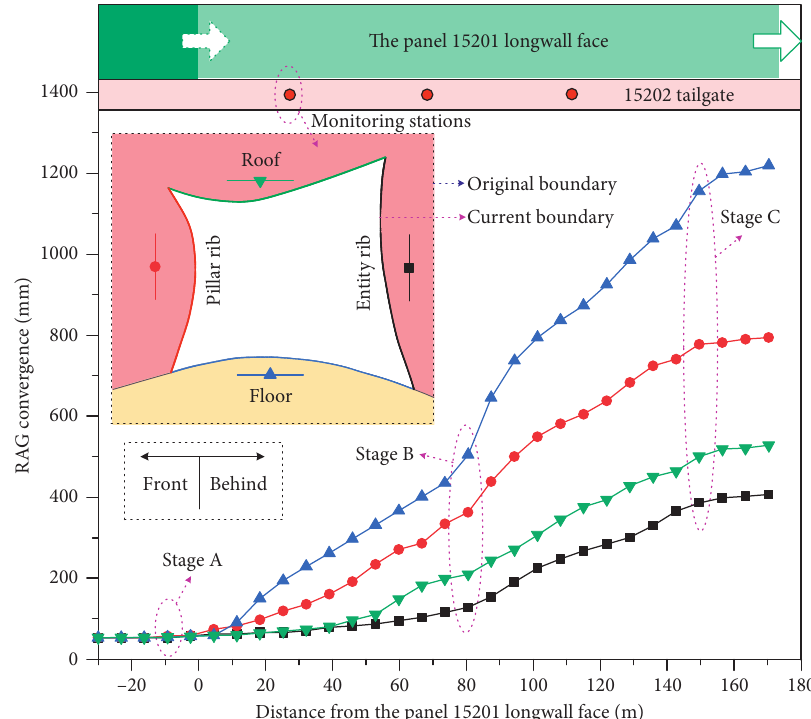
Figure 3: Convergence of the 15202 tailgate versus the panel 15201 longwall face retreat (negative and positive numbers indicate the 15201 longwall face was inby and outby the site, respectively).